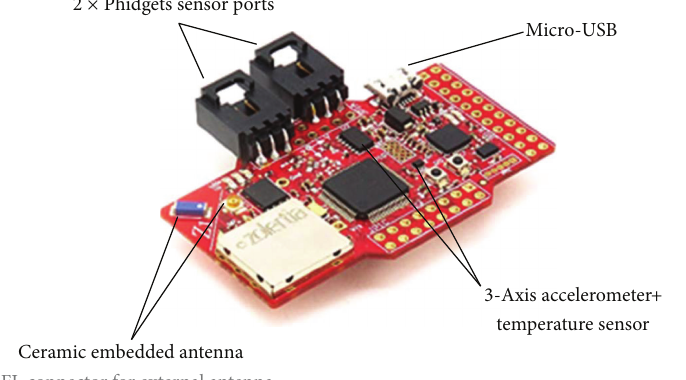
Figure 6: Overall platform detail.